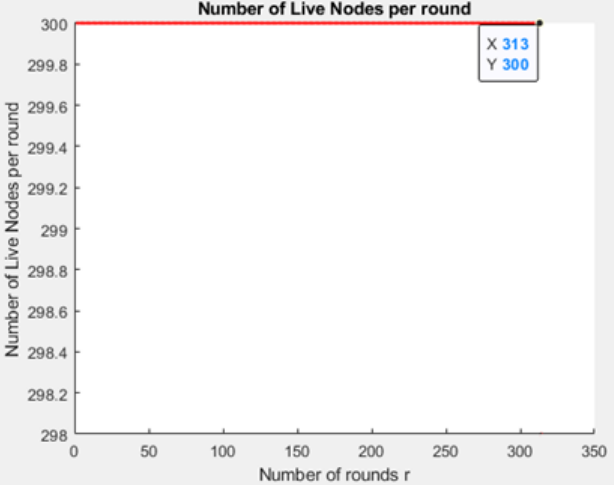
Figure 35. Number of live nodes per round r using the LEACH algorithm in NB-IoT D2D attocell